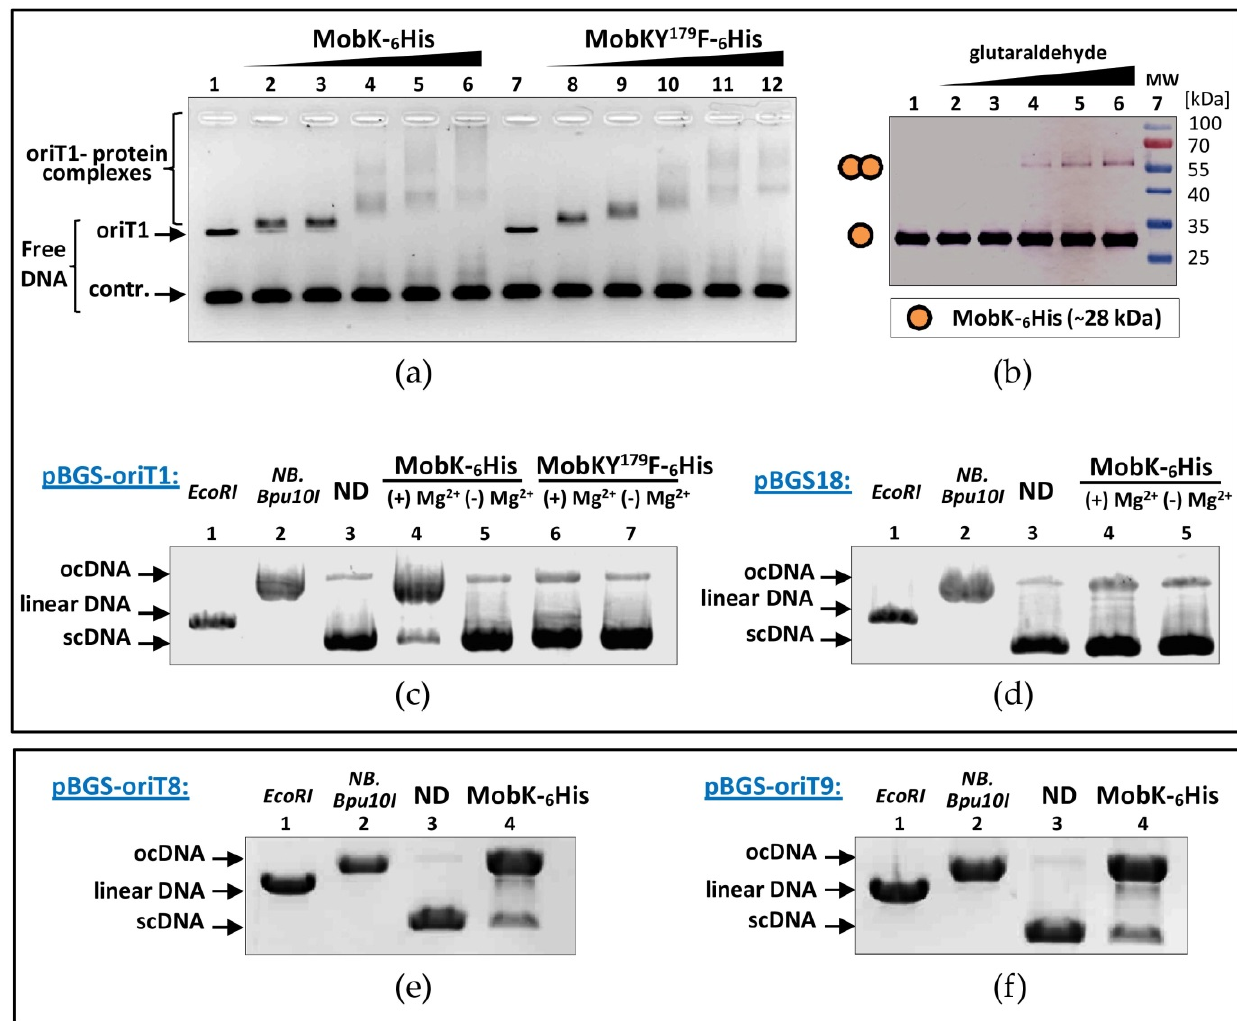
Figure 3. Determination of recombinant MobK protein activities in vitro. ( a ) Electrophoretic mobility shift assay (EMSA), binding of MobK- 6 His and MobKY 179 F- 6 His to fluorescein (FAM)-labeled 592 bp DNA fragment containing pIGRK oriT ; control 136 bp DNA fragment of pBGS18. Lanes (1) and (7): no protein added, lanes (2–6) and (8–12): samples with increasing amount of protein. ( b ) Dimers formation of MobK- 6 His molecules determined using glutaraldehyde cross-linking, lanes:, (1)—MobK- 6 His incubated without glutaraldehyde, (2–6)—MobK- 6 His incubated with increasing concentration of glutaraldehyde, (7)—protein molecular-weight size marker. ( c , d ) Nuclease activity of MobK- 6 His towards supercoiled DNA (scDNA) of plasmid pBGS-oriT1 containing pIGRK oriT ( c ) and empty vector pBGS18 ( d ). To estimate localization of individual DNA forms pBGS-oriT1 ( c ) and pBGS18 (d) scDNAs were digested using EcoRI (generation of linear form), and NB.Bpu10I (generation of open circle, oc form), ND—not digested DNA. Supercoiled plasmid DNA was incubated with MobK- 6 His or MobKY 179 F- 6 His in the presence (+) or absence ( − ) of Mg 2+ divalent cations. ( e , f ) Comparative analysis of MobK- 6 His nuclease activity towards scDNA of: ( e ) pBGS-oriT8 containing minimal oriT ( f ) and pBGS-oriT9 containing oriT8 sequence with deletion of 29 bp.